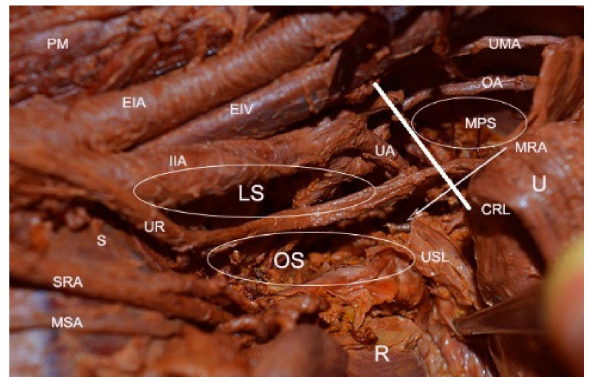
Figure 6. Pararectal space-embalmed cadaver (left side of the pelvis).